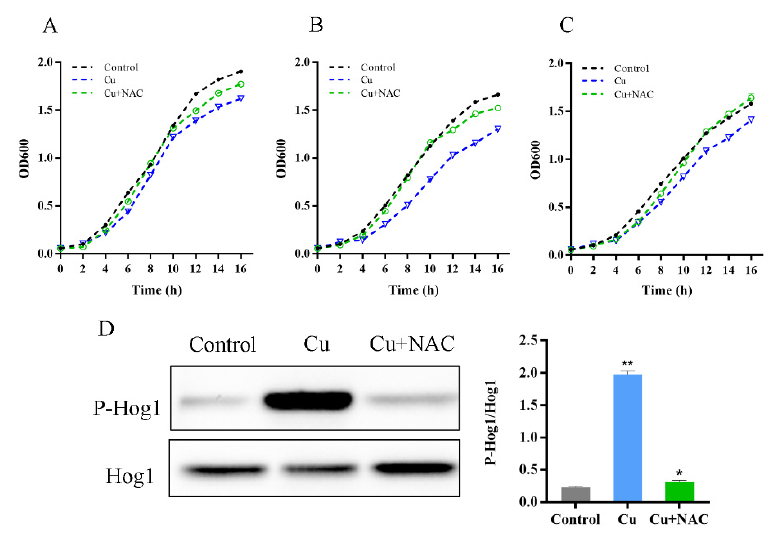
Figure 4. Oxidative stress is essential for the activation of Hog1: the sensitivity of WT, Pbs2 ∆ , and Hog1 ∆ strains to copper were suppressed by NAC addition ( A – C ); ( D ) the addition of NAC reduced Hog1 phosphorylation under copper exposure. * p < 0.05, ** p < 0.01.